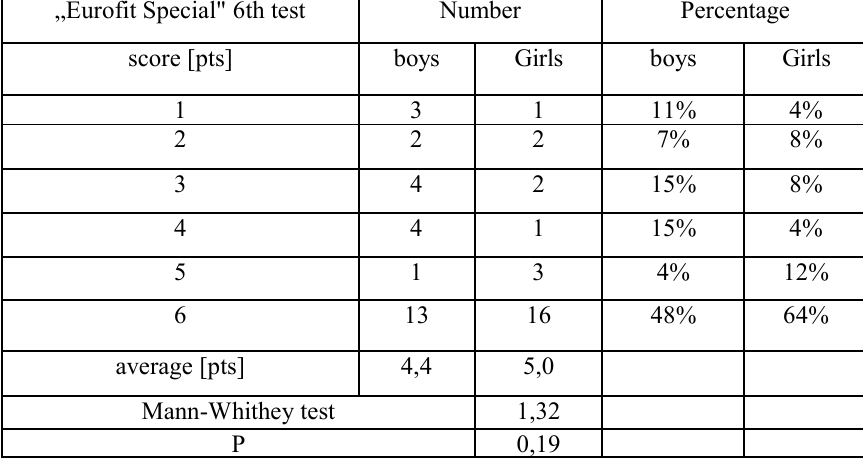
Numbers and percentages of pupils in groups depending on achieved scores in test six „Eurofit Special" 6th